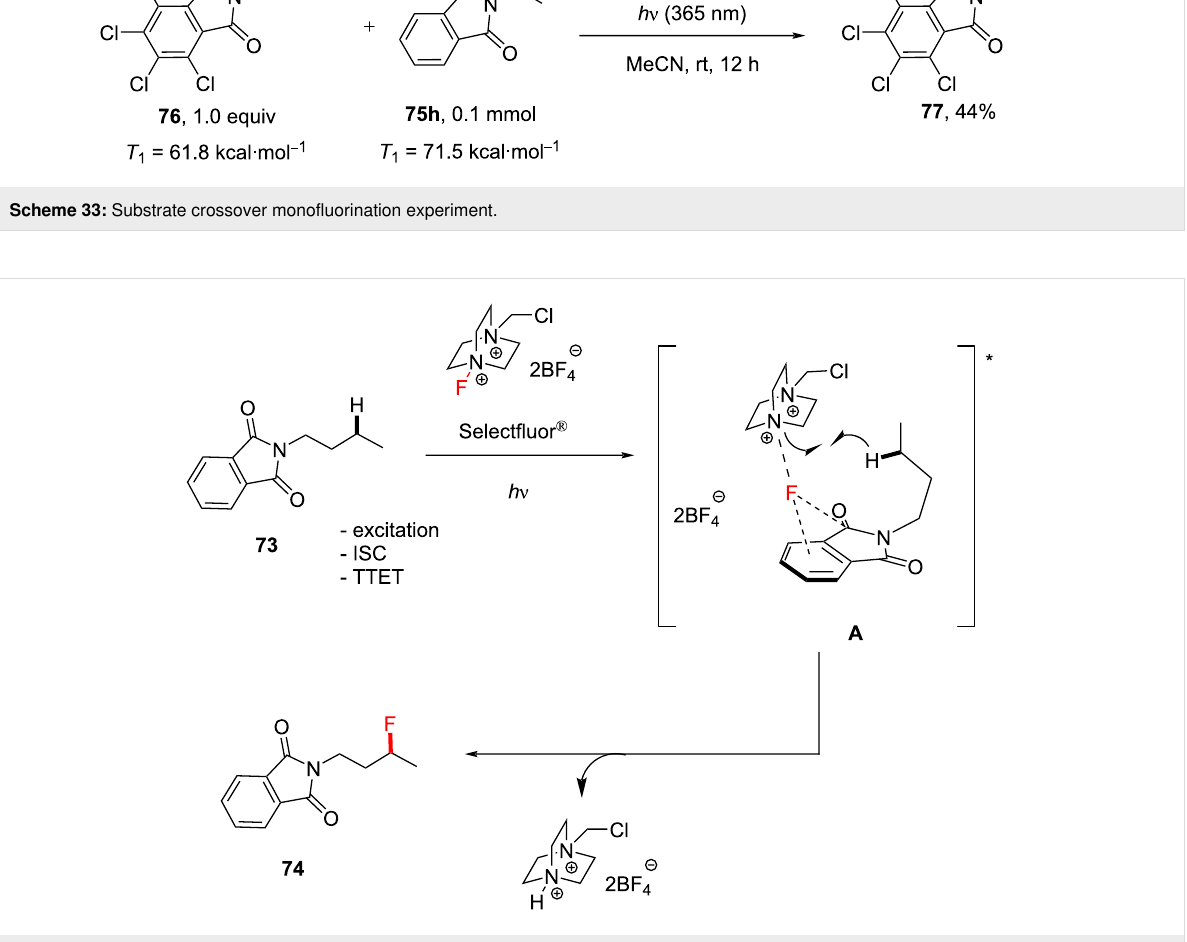
Scheme 34: PS TTET mechanism proposed by Hamashima and